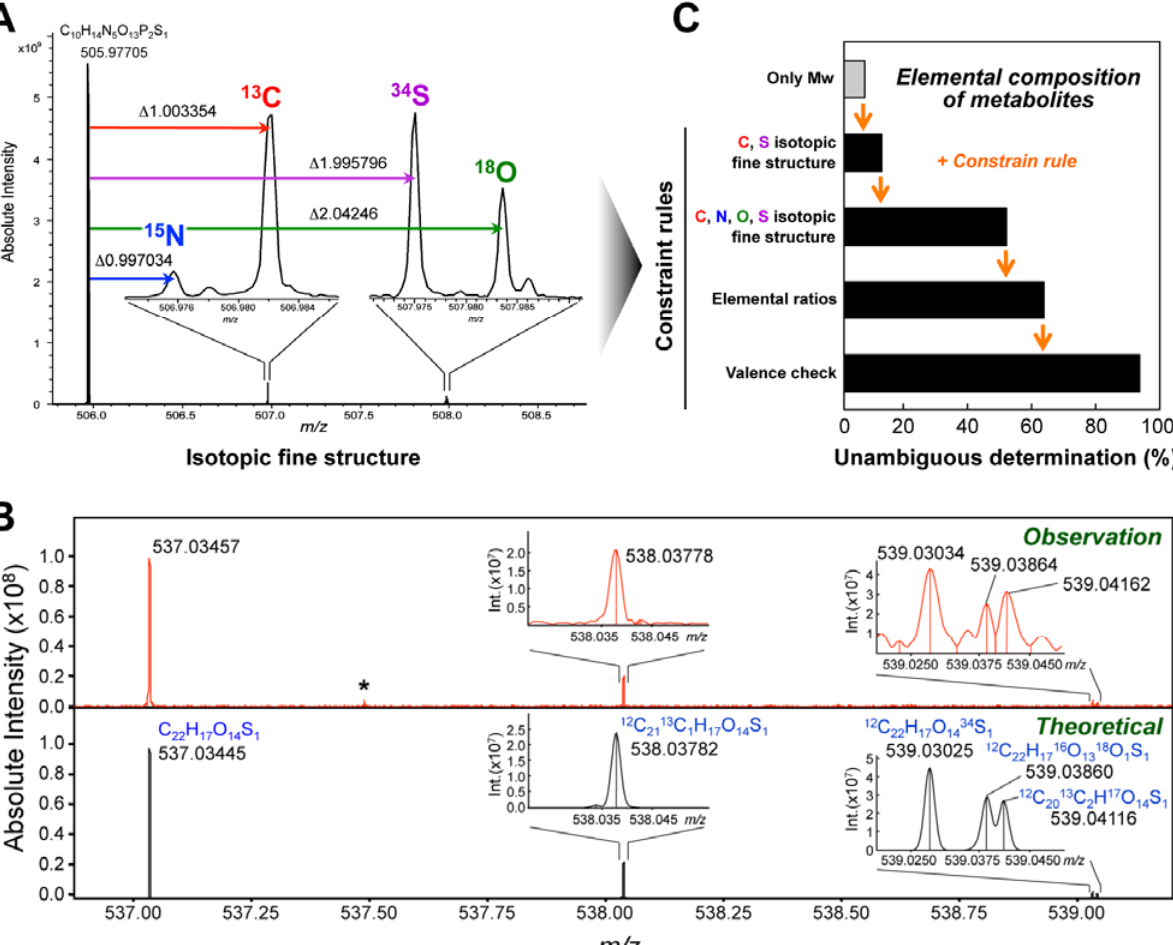
Figure 5. Isotopic fine structure analysis for unambiguous determination of metabolite ECs. ( A ) Mass spectral observation of PAPS (C